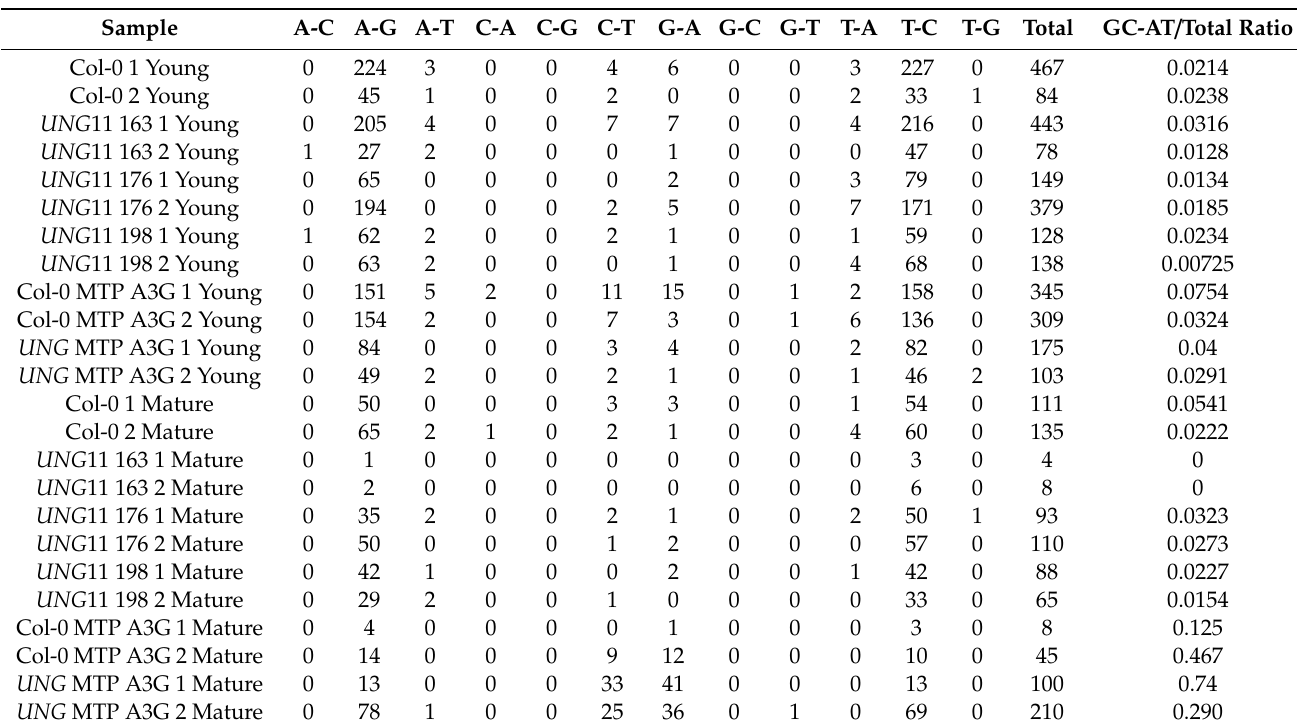
Table 3. Heteroplasmic mitochondrial SNPs in the next generation of Col-0 wild-type, UNG mutant lines, Col-0 MTP-A3G, and UNG MTP-A3G: SNPs were called using VarDict as described in the Methods section. SNP counts are shown for the entire mitochondrial genome. For the full spectrum of SNP types, including allele frequencies, see Supplementary File